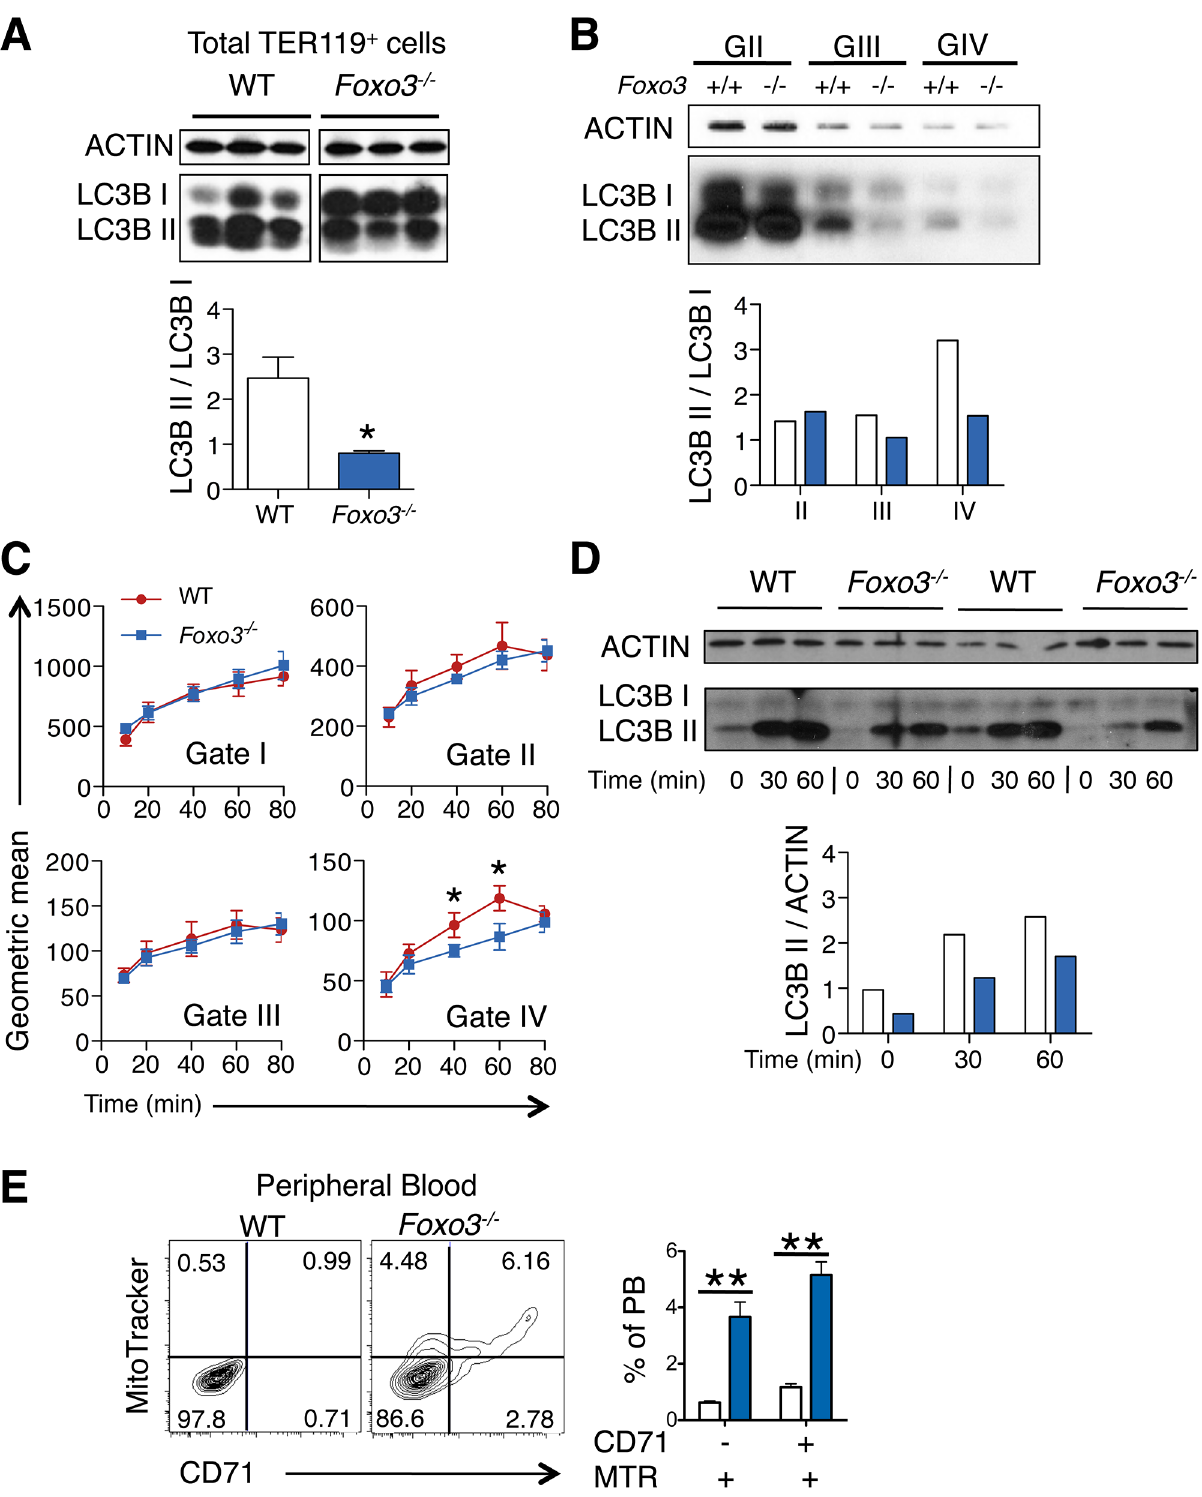
Fig 3. Autophagy and mitochondrial removal are impaired in Foxo3 -/- erythroblasts (A) Western blot analysis of LC3B protein of WT and Foxo3 -/- bone marrow TER119 + cells (n = 3 mice for each genotype). Quantification of the LC3BII/ LC3B-I ratio in one representative of two independent experiments is shown (bottom panel). (B) Western blot analysis of LC3B protein extracted from WT and Foxo3 -/- bone marrow erythroblasts Gates II to IV (insufficient Gate I cell numbers for Western blot). Quantification of the LC3B-II/LC3B-I ratio is shown (panel below). (C) Autophagic flux in WT and Foxo3 -/- bone marrow